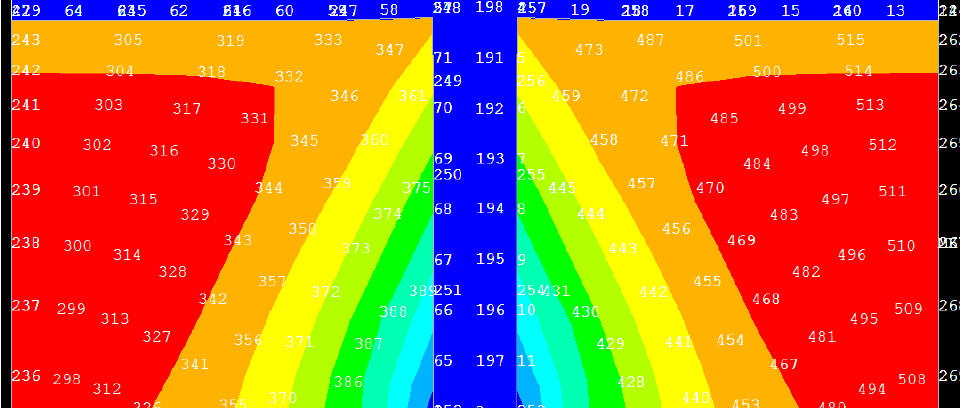
Figure 4. Part of resist displacement (magnified) from Figure 3.